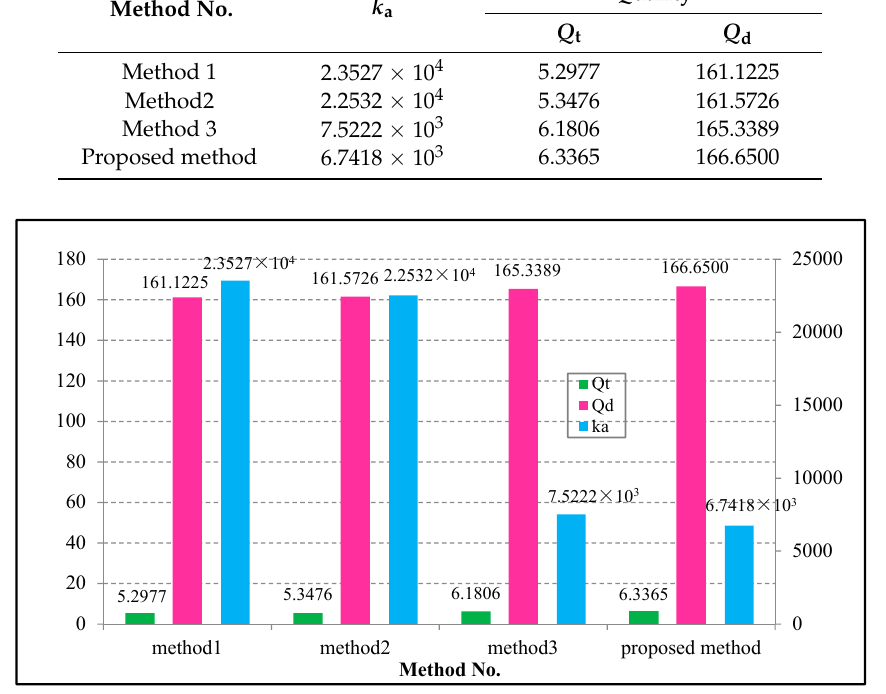
Table 4. The condition number and quality of the four methods in 14 bus system.